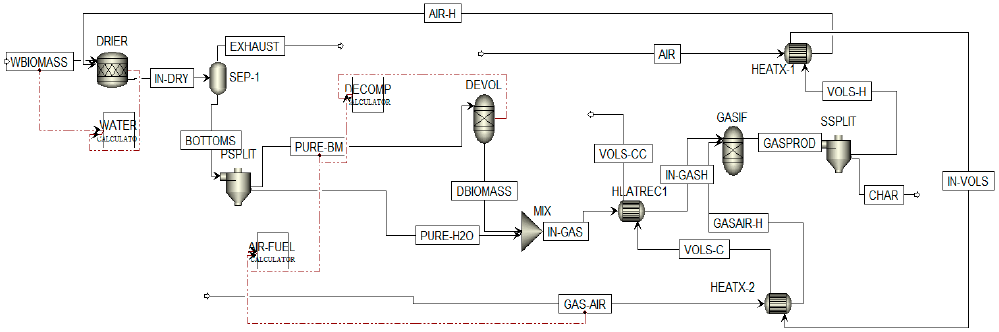
Figure 7. Heat recovery for gasification.